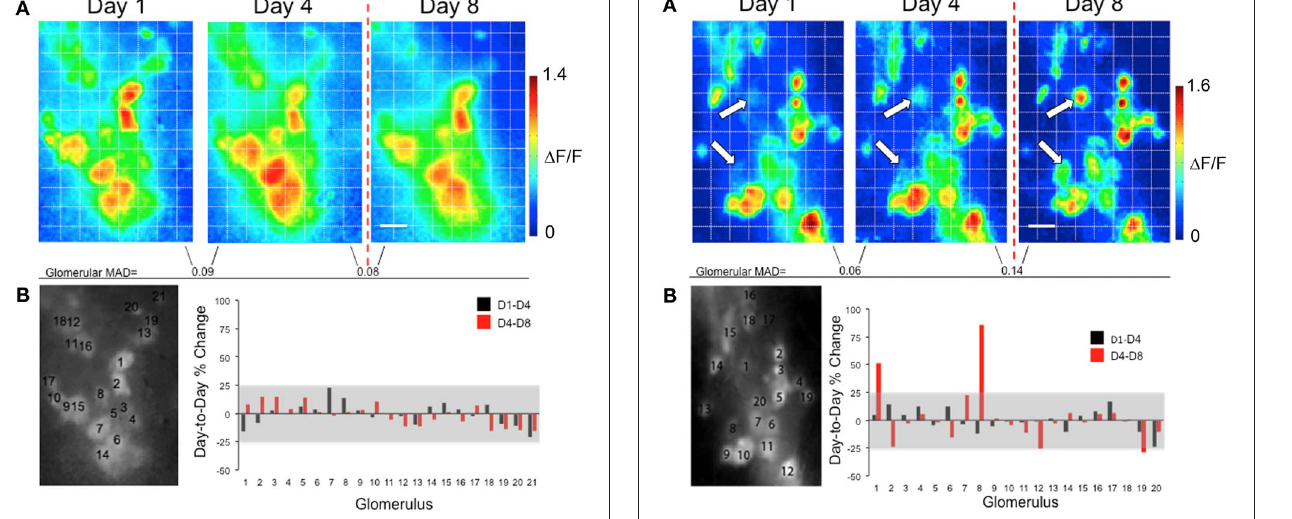
FIGURE 4 | Presentations of odor alone do not significantly alter glomerular G-CaMP2 odor representations in individual mice. (A) Methyl valerate response maps taken from Day 1 and Day 4 prior to any conditioning and are similar across the days. The last map (Day 8) was taken one day after exposing the animal to presentations of odor only. No dramatic changes in response amplitude were seen in glomeruli on the day following the foot shock presentations. The Mean Absolute Day-to-Day Difference (MAD) for each glomerulus remained similar before and after training. Scale bar: 100 μ m (B) The left panel indicates the position of the glomeruli. The graph represents the percent change in response for each glomerulus across days. The gray box represents the pre-training percent change (mean ± 2SD) taken from all glomeruli across all three groups. Again, no significant changes in response amplitude were observed across days.